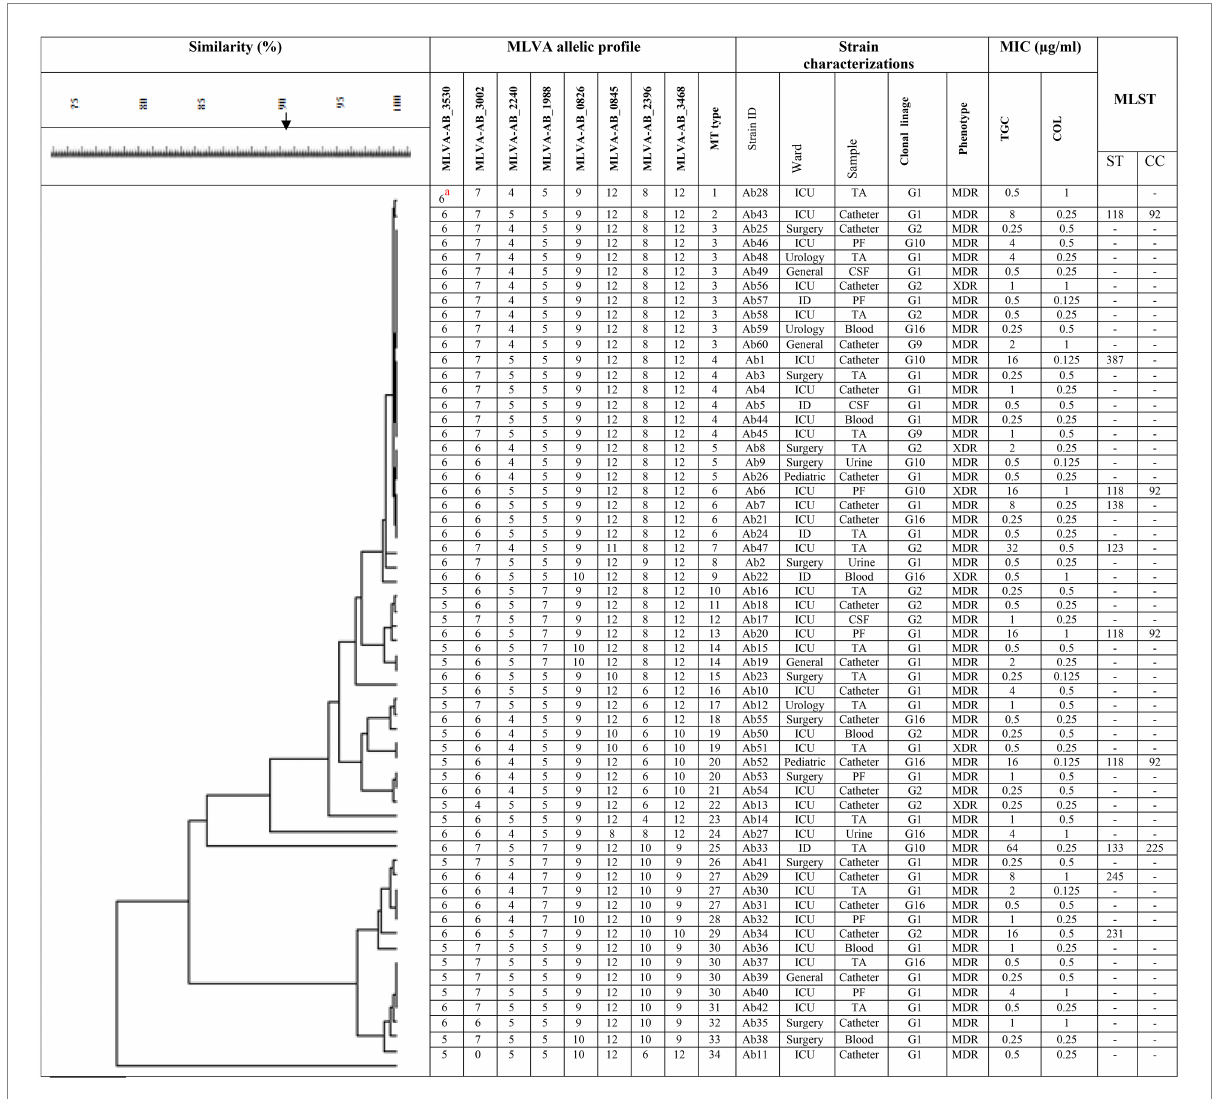
FIGURE 2 Dendogram shows the genetic diversity of 60 A. baumannii isolates by MLVA and MLST. Ab 1, A. baumannii number 1; TA, tracheal aspirates; PF, pleural fluid; IC,: International clonal linage; MDR, multidrug resistant; XDR, extensively drug-resistant; MIC, minimum inhibitory concentration; TGC, tigecycline; COL, colistin; CC, clonal complex; ST, sequence type. a The number of repeats in VNTR alleles for each